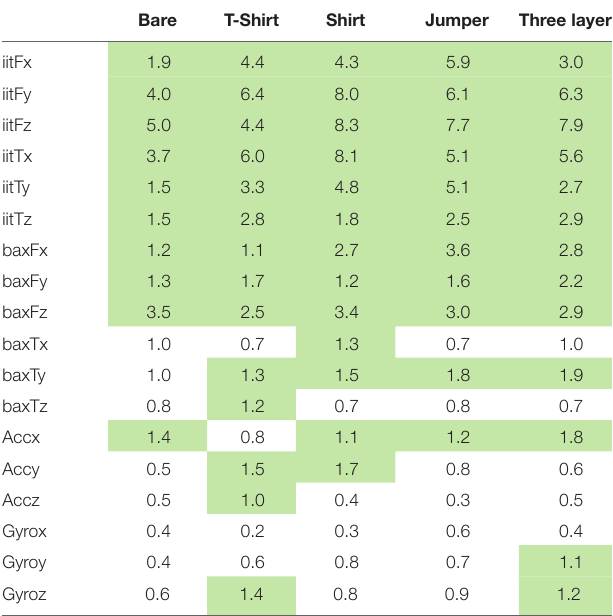
TaBle 4 | error analysis results for each sensor and axis combination.